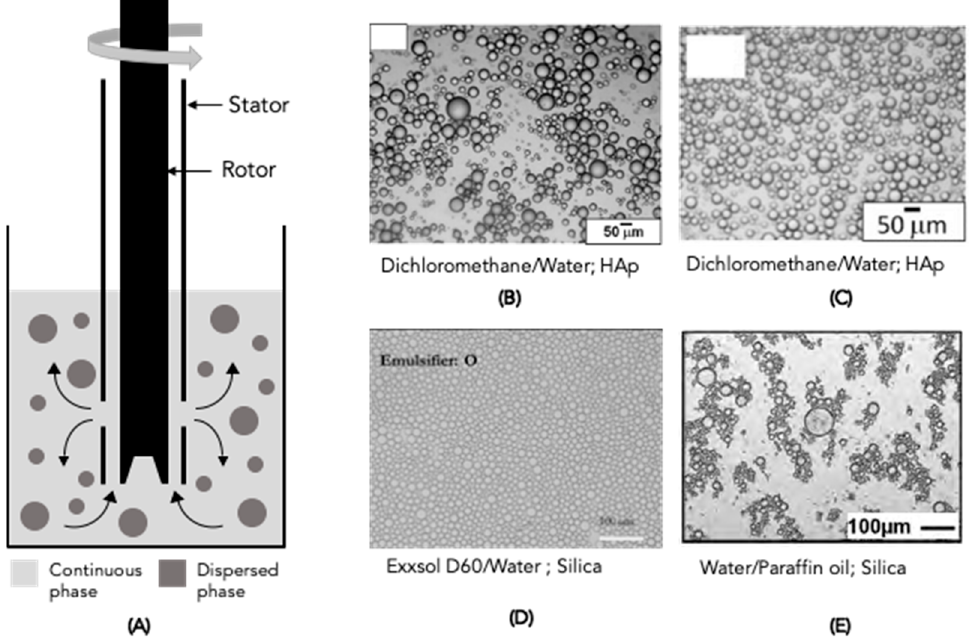
Figure 4. Schematisation of rotor-stator device ( A ), and some examples of PEs (( B ) [127], ( C ) [131], ( D ) [44] and ( E ) [100]). (Reprinted from [127], Copyright (2012), with permission from Elsevier; Reprinted from [131], Copyright (2013), with permission from Taylor and Francis; Reprinted from [44], Copyright (2017), with permission from Elsevier; Reprinted from [100], Copyright (2010), with permission from Elsevier).